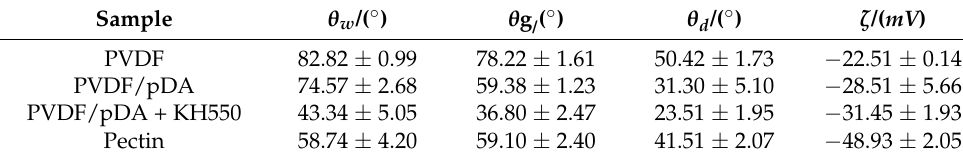
Table 4. Contact angle and zeta potentials of membranes and